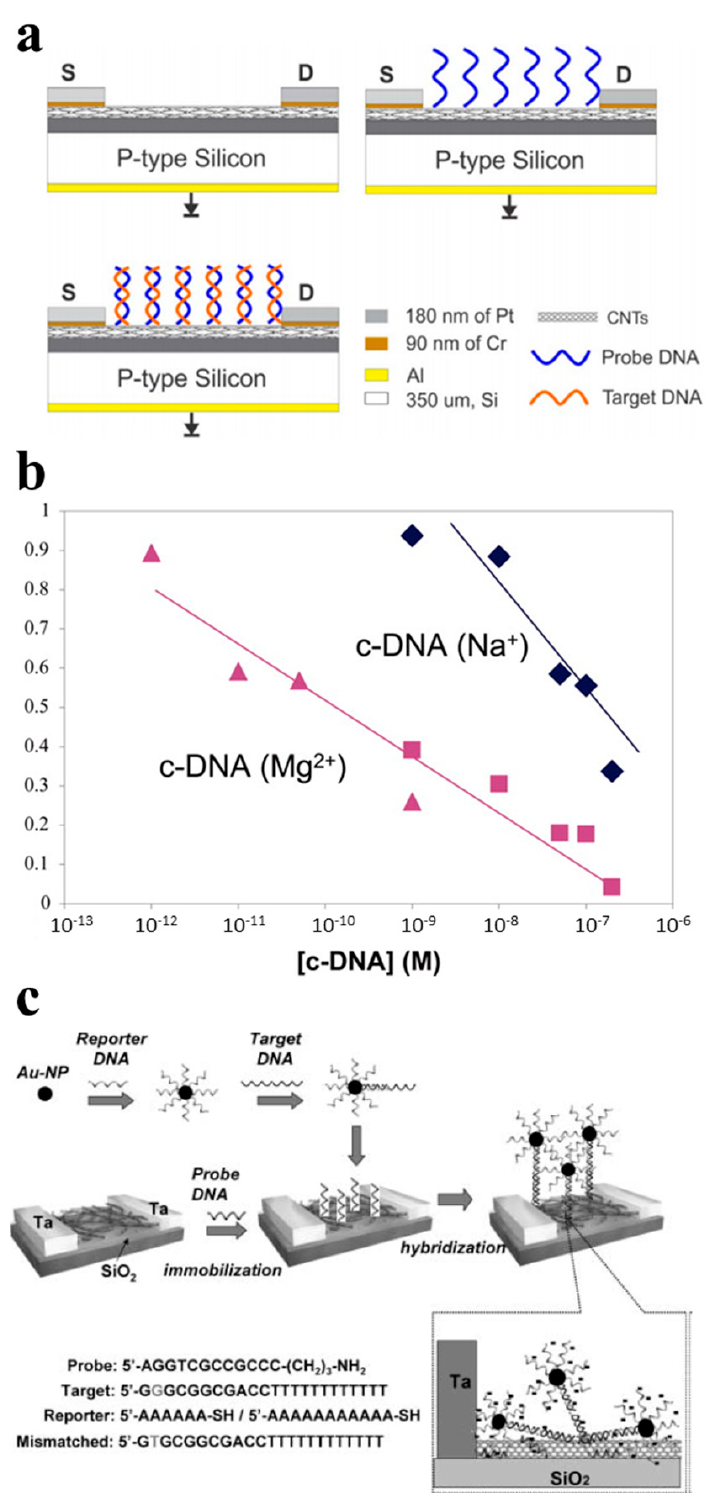
Figure 7. CNTFET-based sensors for DNA detection. ( a ) Working principle of CNTFET-based DNA sensors [91]. ( b ) Normalized conductance as a function of target DNA concentrations [87]. ( c ) Schematic illustration of DNA detection with reporter DNA conjugated with Au nanoparticles [88].